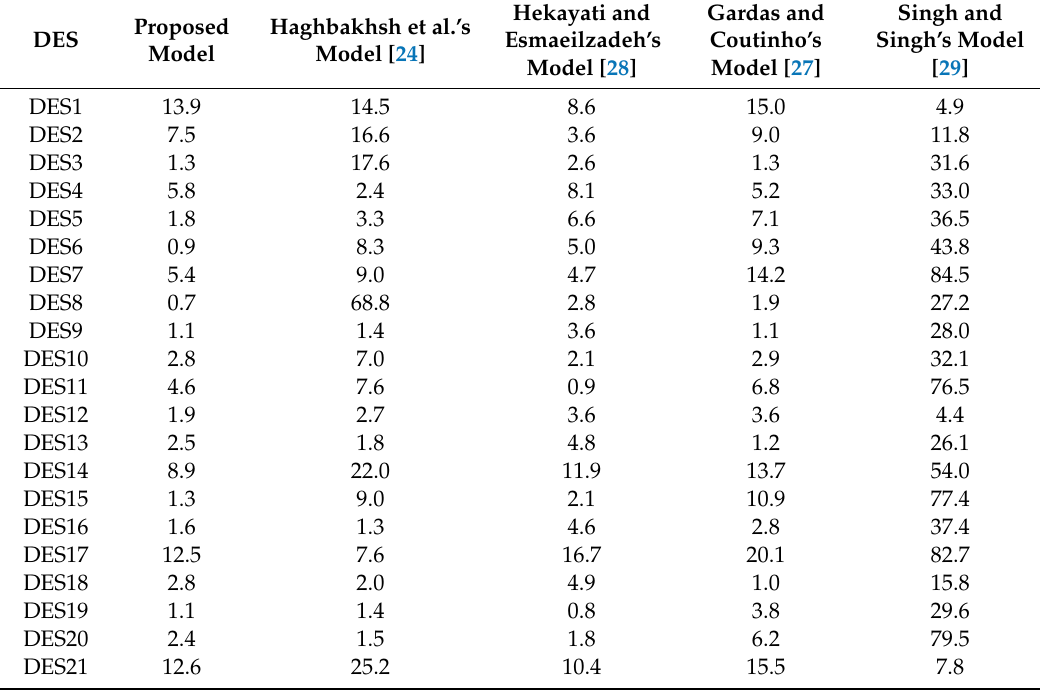
Table 4. Comparison of the values of AARD% for the proposed model and literature models for each of the investigated